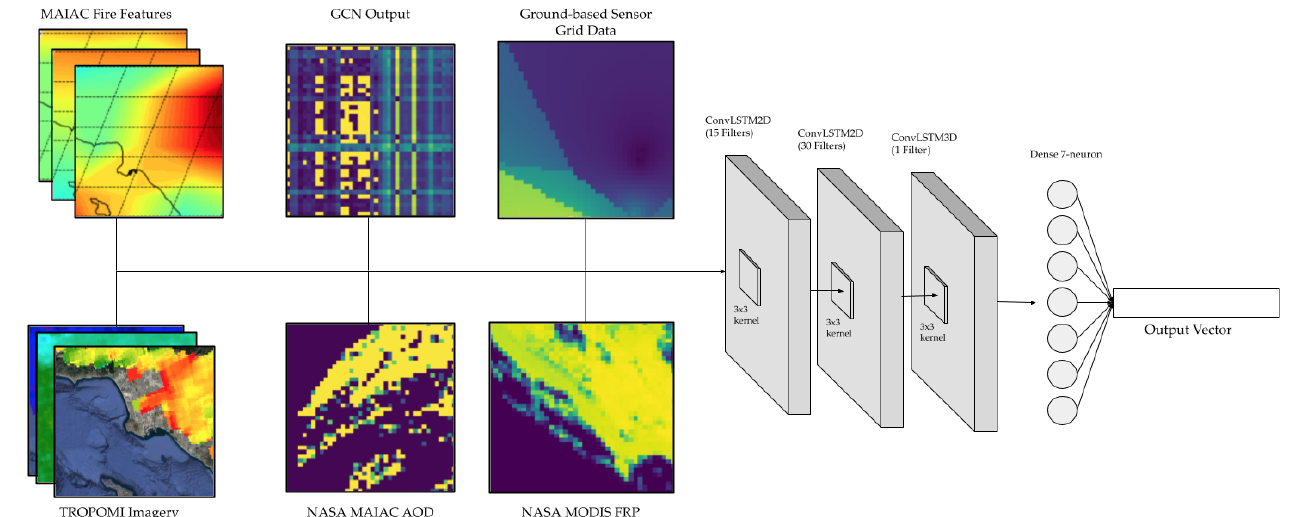
Figure 3. Visualization of the ConvLSTM module of our model